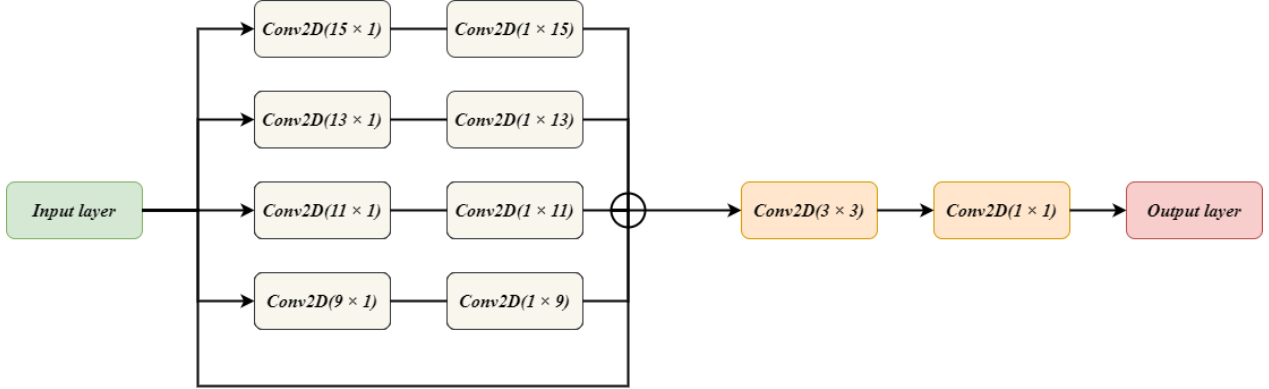
Figure 3. The Architecture of FE Block used in